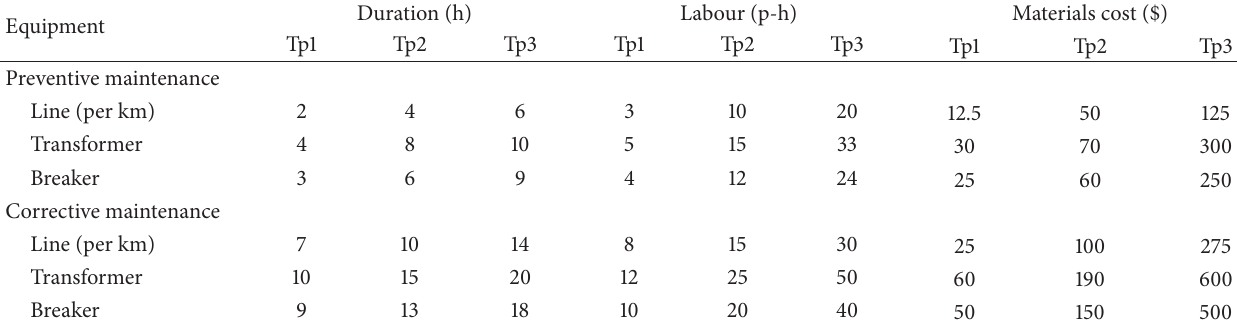
Table 2: Maintenance data of different deterioration mechanism types and equipment.